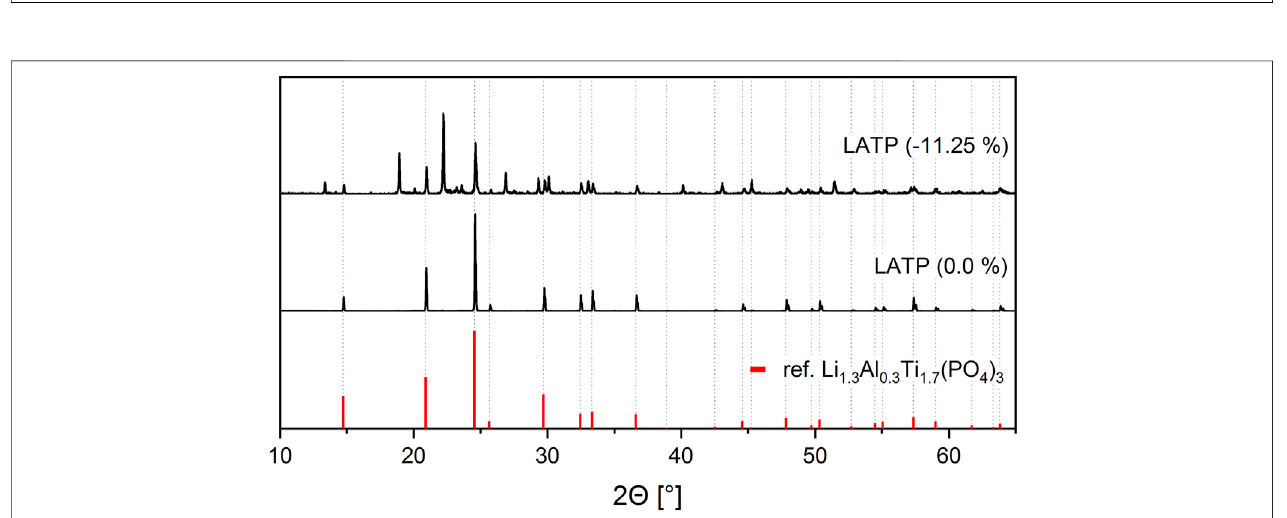
FIGURE 5 | X-ray diffraction patterns for the LATP ( − 11.25 wt%) sample sintered at 1,000 ° C for 450 min and one LATP (0.0 wt%) sample sintered at 900 ° C for 30 min. A standard X-ray diffraction pattern of Li 1.3 Al 0.3 Ti 1.7 (PO 4 ) 3 from the database is shown in red color for reference.